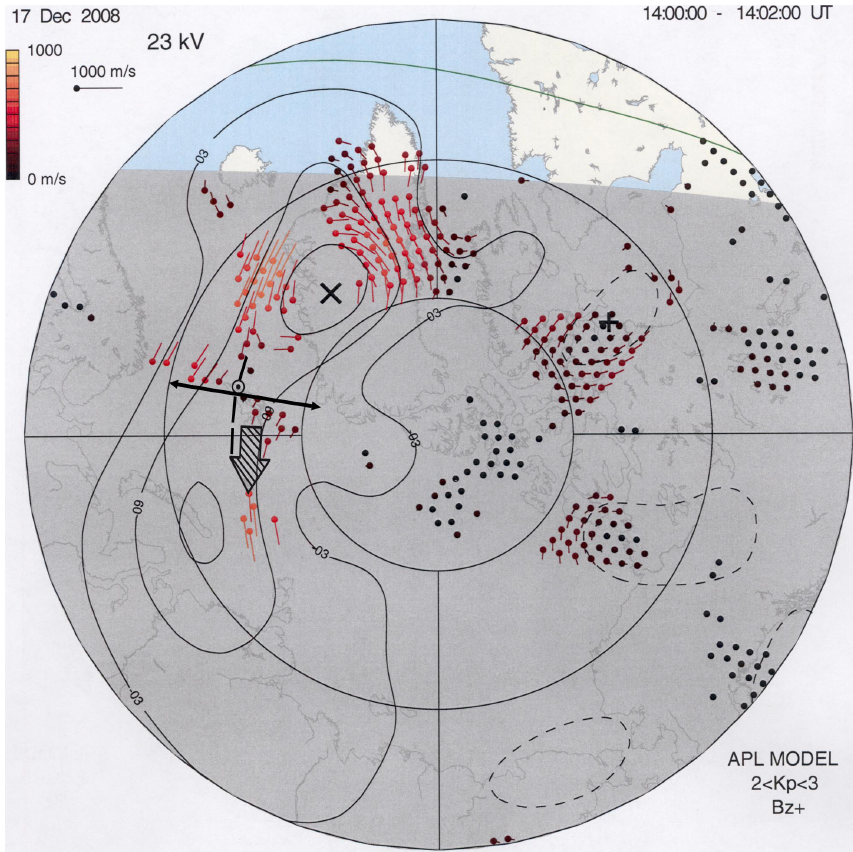
Fig. 10. SuperDARN spatial convection plot for 14:00–14:02UT. Ground station Hornsund (HOR) on Svalbard (17 MLT; 74 ◦ MLAT), flow channel FC 2 and the approximate location of discrete aurora (poleward boundary/dashed line) as observed by meridian scanning photometer (MSP) in Longyearbyen (75 ◦ MLAT) have been marked by dotted circle, hatched arrow (in addition to the ion drift vectors in the antisunward direction), and double-arrowed meridional line, respectively. The latter is the Longyearbyen MSP field of view in the the 630.0nm emission